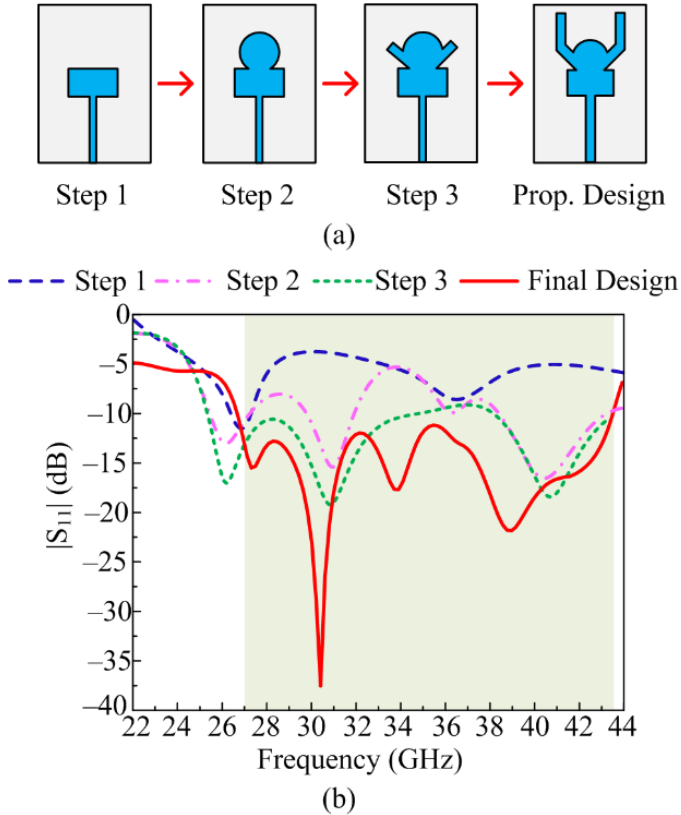
Figure 2. ( a ) Designing steps; ( b ) corresponding results.